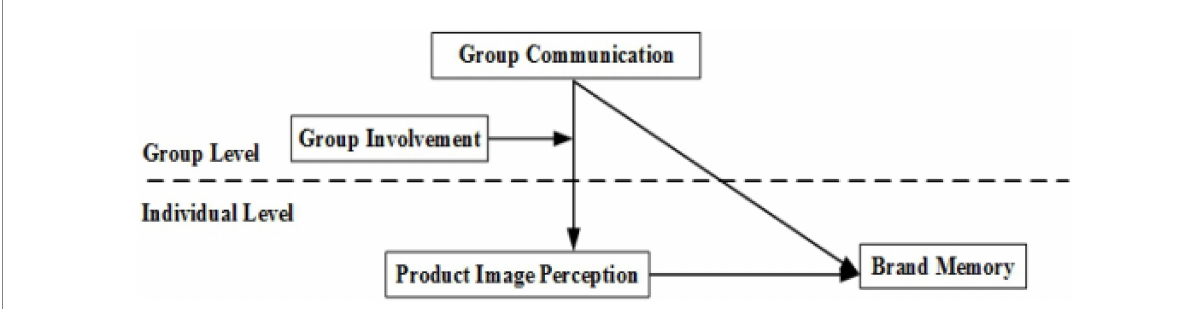
FIGURE 1 Conceptual model of how consumer group communication influences consumer brand